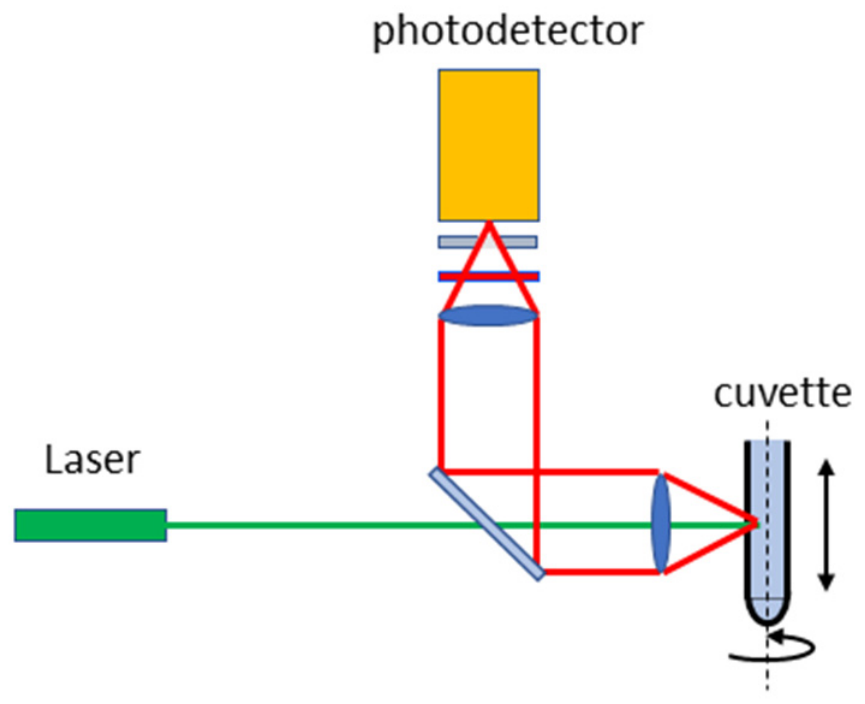
Figure 1. Schematic of the proposed MP detection instrument.